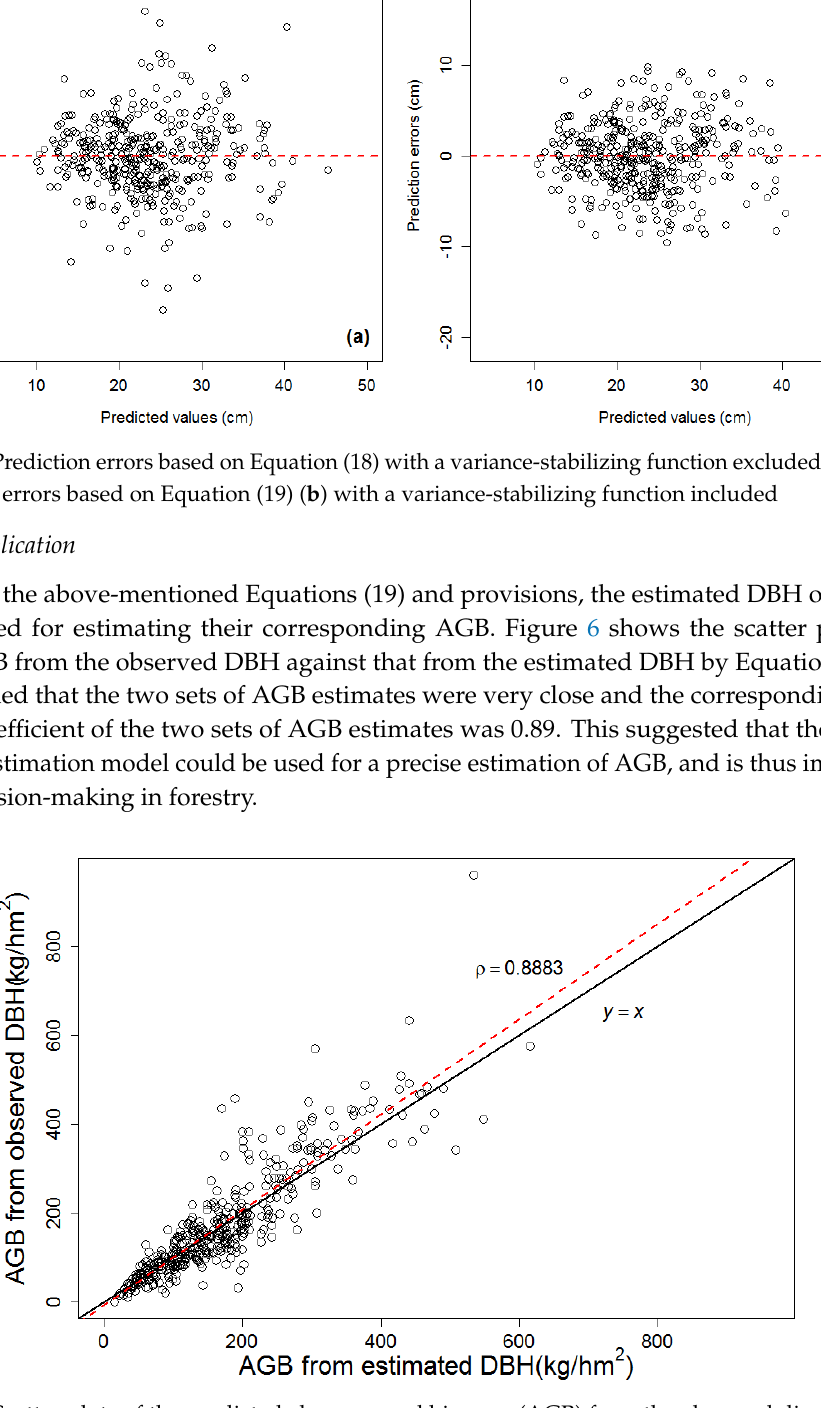
Figure 6. Scatter plots of the predicted aboveground biomass (AGB) from the observed diameter at breast height (DBH) against that from the estimated DBH by Equation (19), with the red dotted line illustrating a linear relationship between two variables, black line denoting y x  ,  is the correlation coefficient of the predicted AGB from the estimated DBH by Equation (19) and the observed